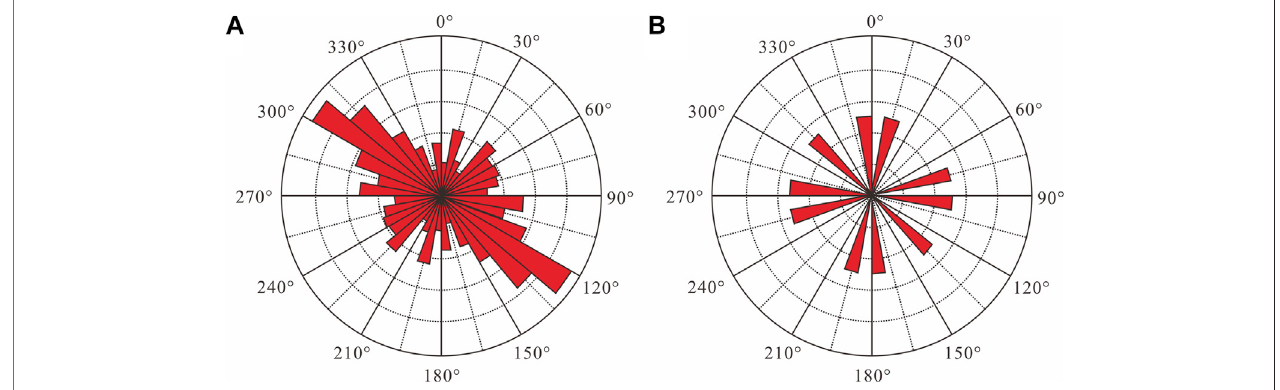
FIGURE 11 | Strikes of the fractures in the Yuanba Gas Field. (A) Changxing Formation; (B) Feixianguan Formation.